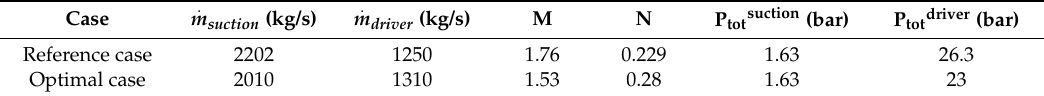
Table 4. Comparison conditions for reference case and optimal performance.